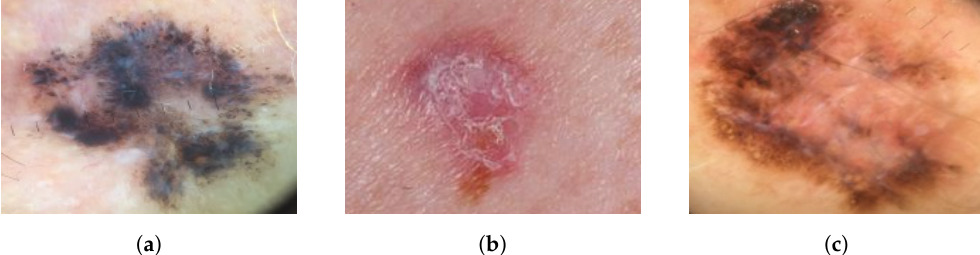
Figure 1. Principal types of malignant skin cancer (sources: [10] and Dermatology Unit, Department of Clinical Internal Anesthesiologic Cardiovascular Sciences, “La Sapienza” University of Rome).